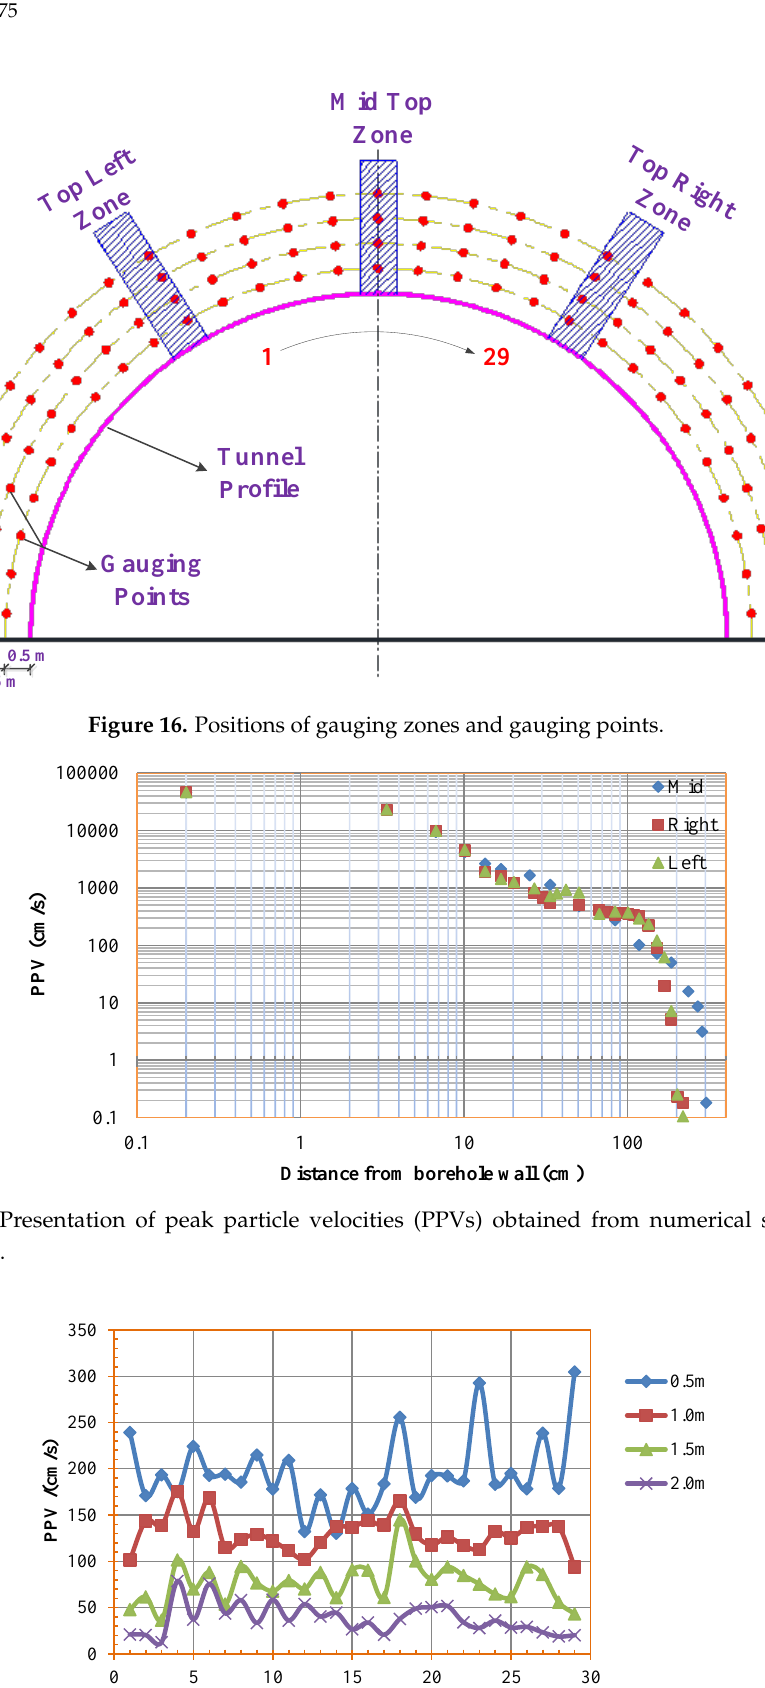
Figure 18. PPVs for different distances obtained from numerical study. Table 3. Estimation of damage degree by PPV for the bedded tunnel Distance (m) PPV Concentrated Range (cm/s)